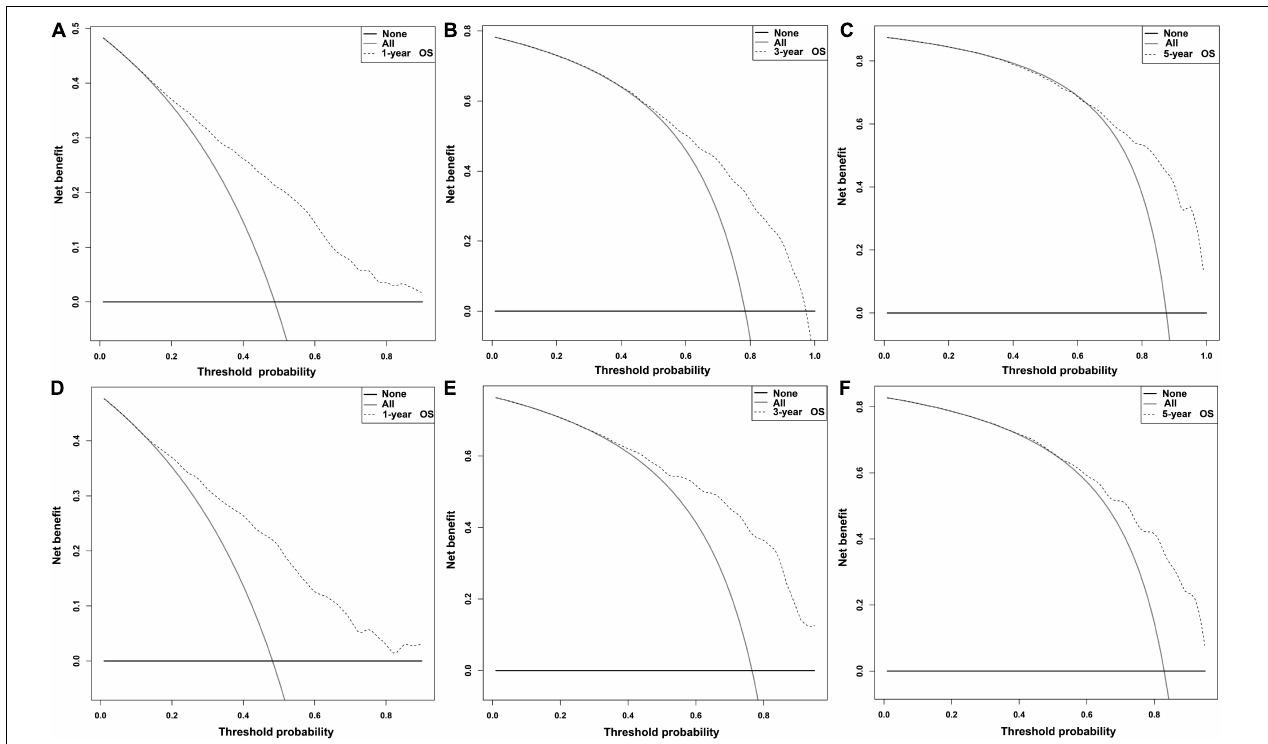
FIGURE 11 | DCA plots of the nomogram. (A–C) DCA plots of the 1-, 3-, and 5- OS in the training dataset. (D–F) DCA plots of the 1-, 3-, and 5-year OS in the testing